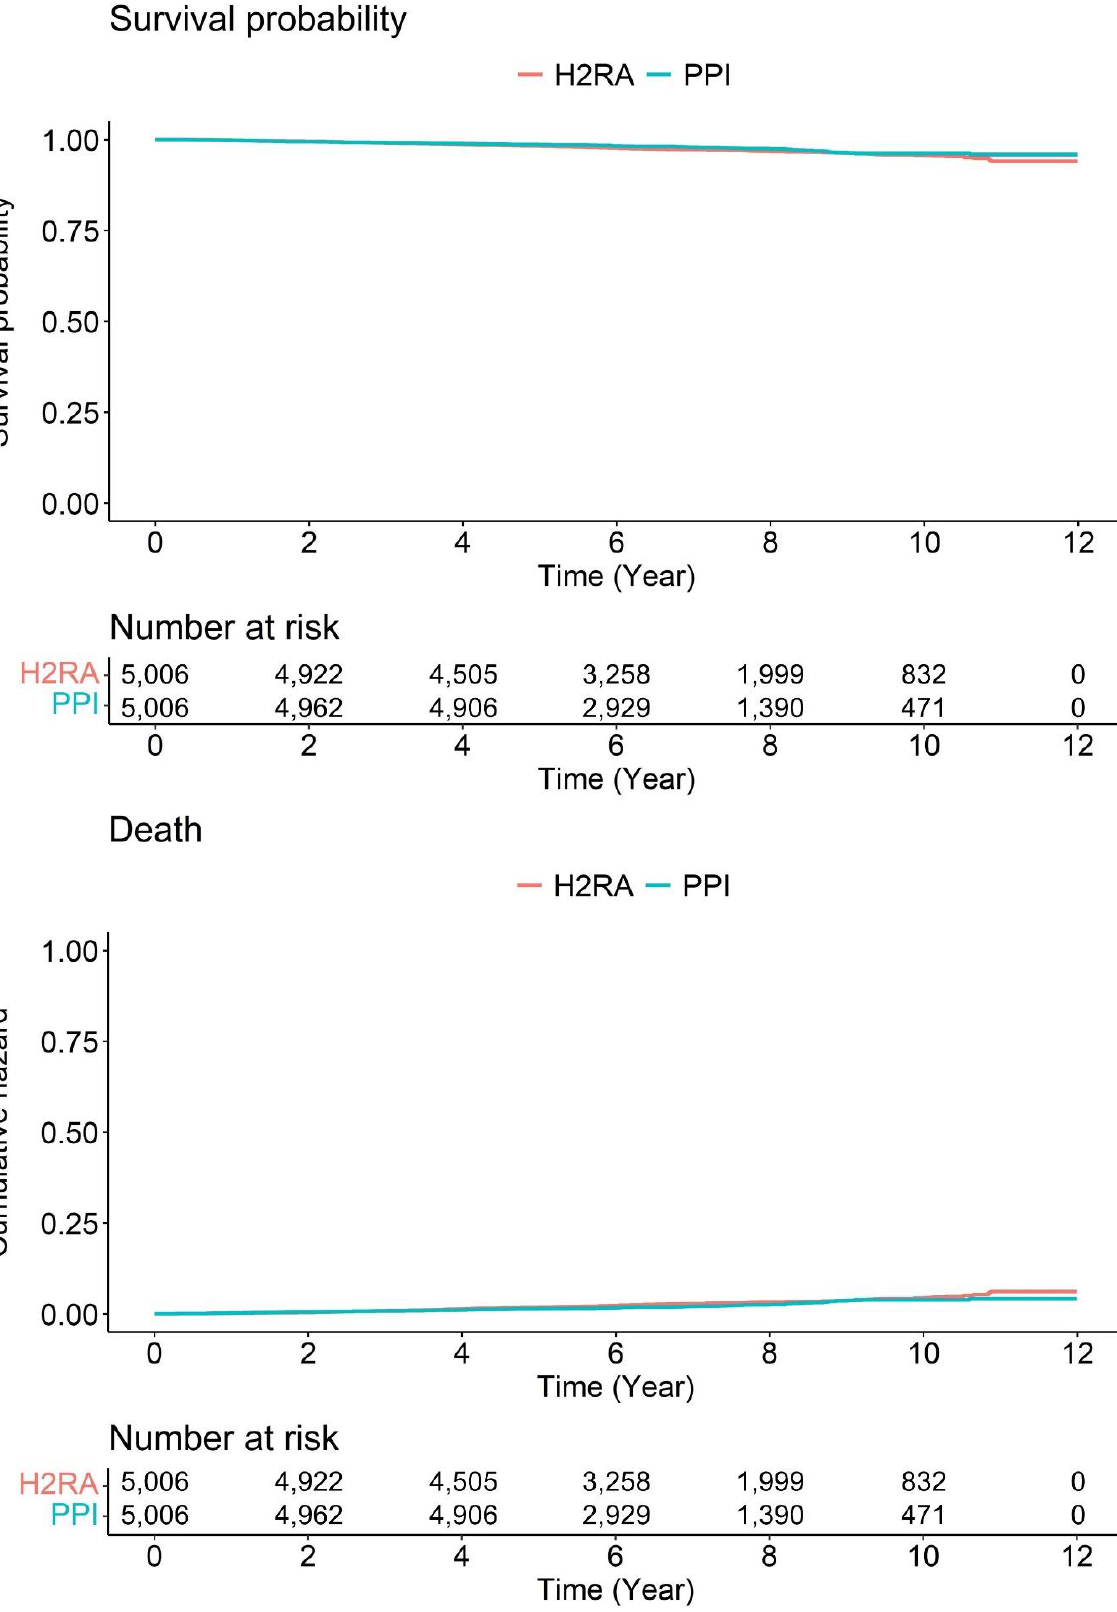
Figure 3. Survival curves of enrolled subjects. H 2 RA, histamine-2 receptor antagonist; PPI, proton pump inhibitor.